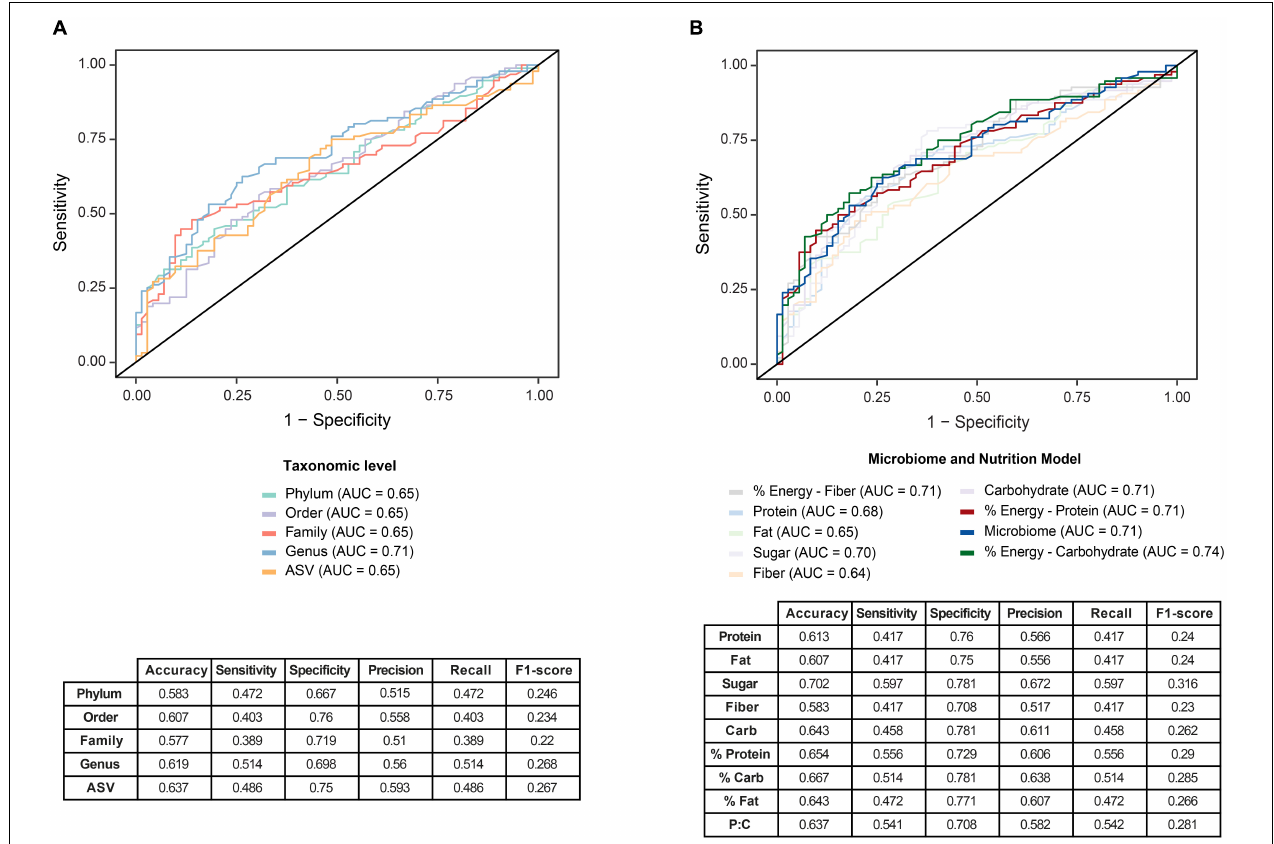
FIGURE 4 | Predictive modeling to identify Parkinson’s disease (PD) was optimized by a two-stage model that incorporates nutritional and microbiome data. (A) Predictive Random Forest modeling was undertaken to identify the utility of the gut microbiome as a potential signature for PD. Comparisons at five taxonomic levels; phylum, order, family, genus and ASV, were used to predict PD, with greatest predictive capacity provided at the genus level on receiver operating characteristic curve (ROC), with an area under the curve (AUC) of 0.71. (B) An optimized two-stage predictive Random Forest model analysis was subsequently undertaken that considered dietary intake as an influence on the gut microbiome. Comparing the utility of the one-stage microbiome model (AUC = 0.71) with the two stage model, a slightly improved predictability was achieved. when incorporating dietary macronutrient data. Specifically, the incorporation of carbohydrate contribution to total energy in the model improved the prediction (AUC = 0.74), whereas incorporation of fiber, fat or protein macronutrient data alone into the model did not improve the predictive potential to identify PD. Accompanying sensitivity and specificity analyses are presented in the